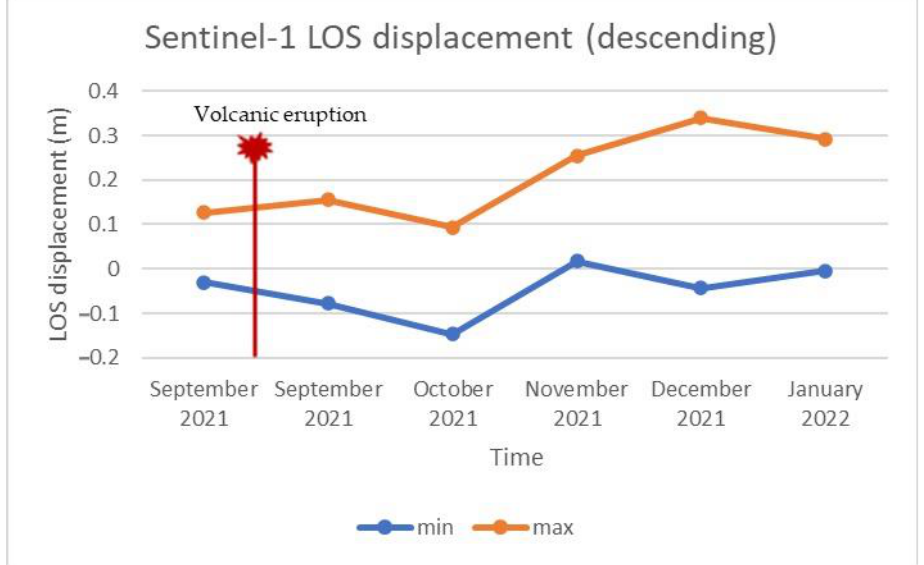
Figure 9. Multitemporal LOS displacement over the entire eruptive period, obtained by processing the Sentinel-1 descending imagery.